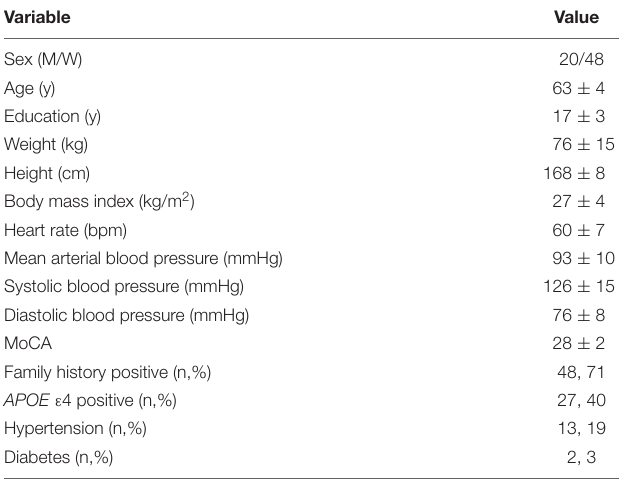
TABLE 1 | Participant characteristics and selected cardiovascular variables at